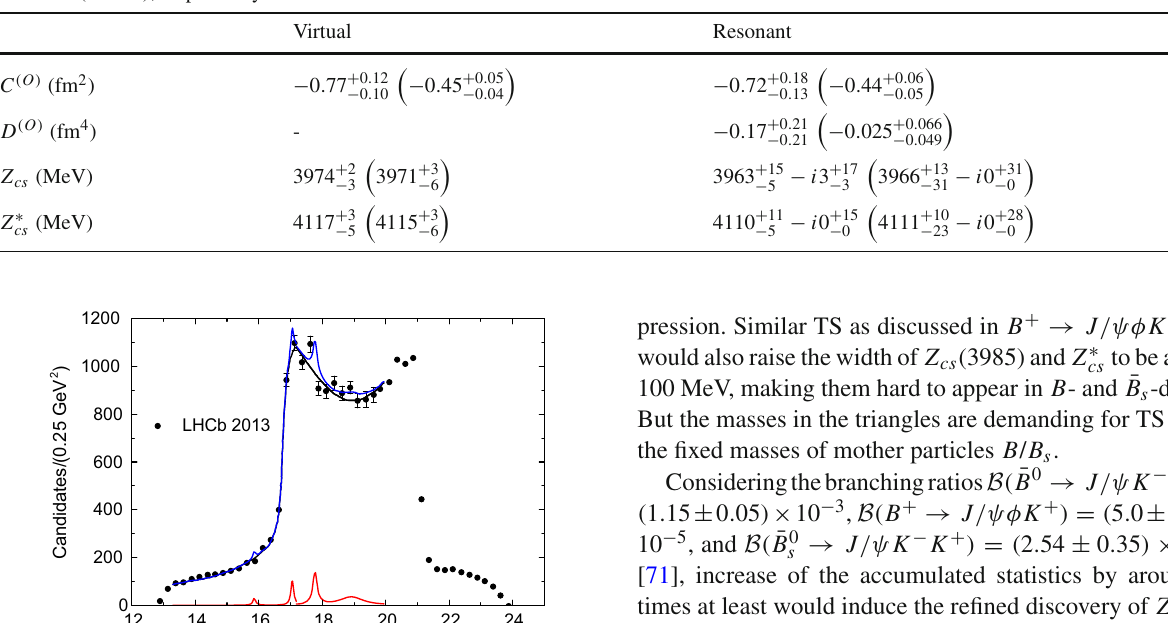
Table 1 Parameters of contact interaction and poles of Z ( ∗ ) cs taken from Ref. [28]. Results outside (inside) brackets are for cutoff (cid:5) = 0 . 5 GeV ( 1 GeV ) , respectively